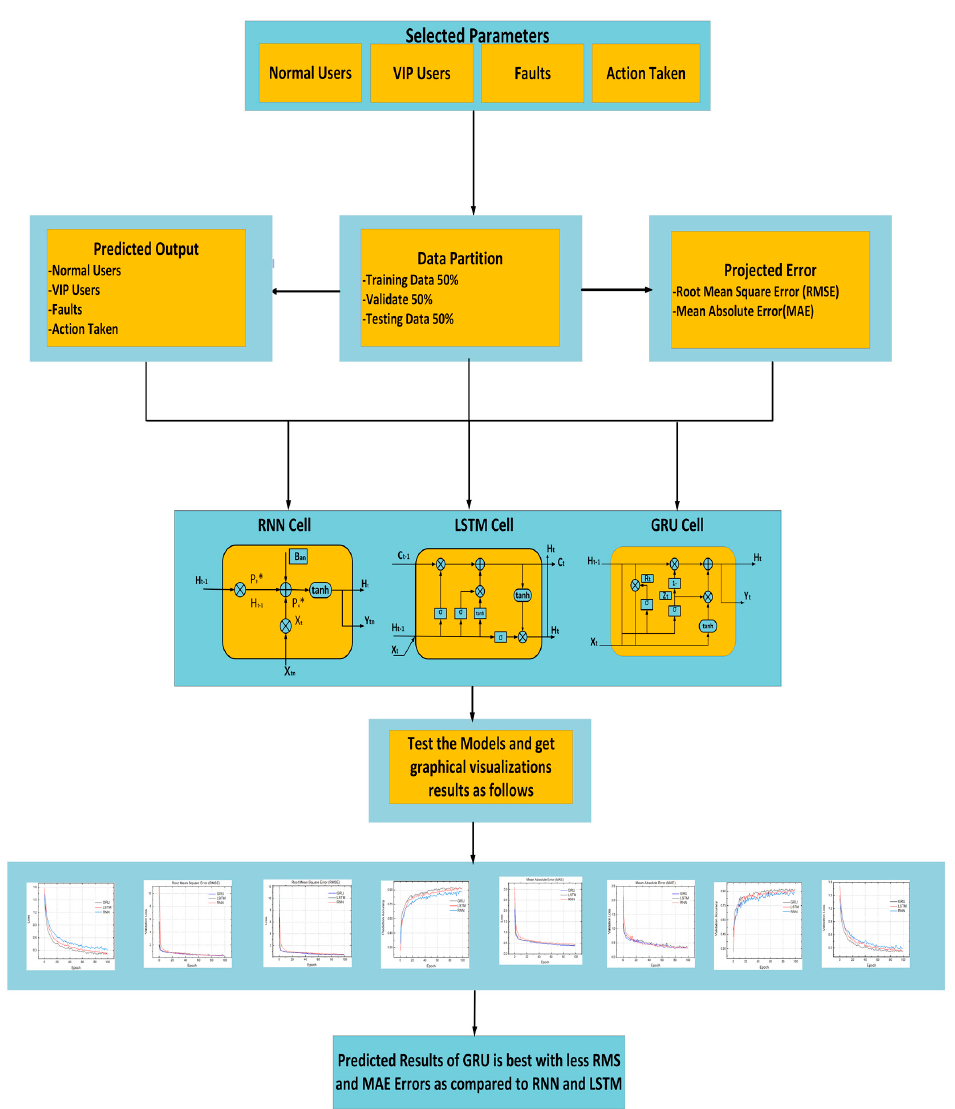
Figure 4. Proposed framework to find the best model for Fault Management Perdition.